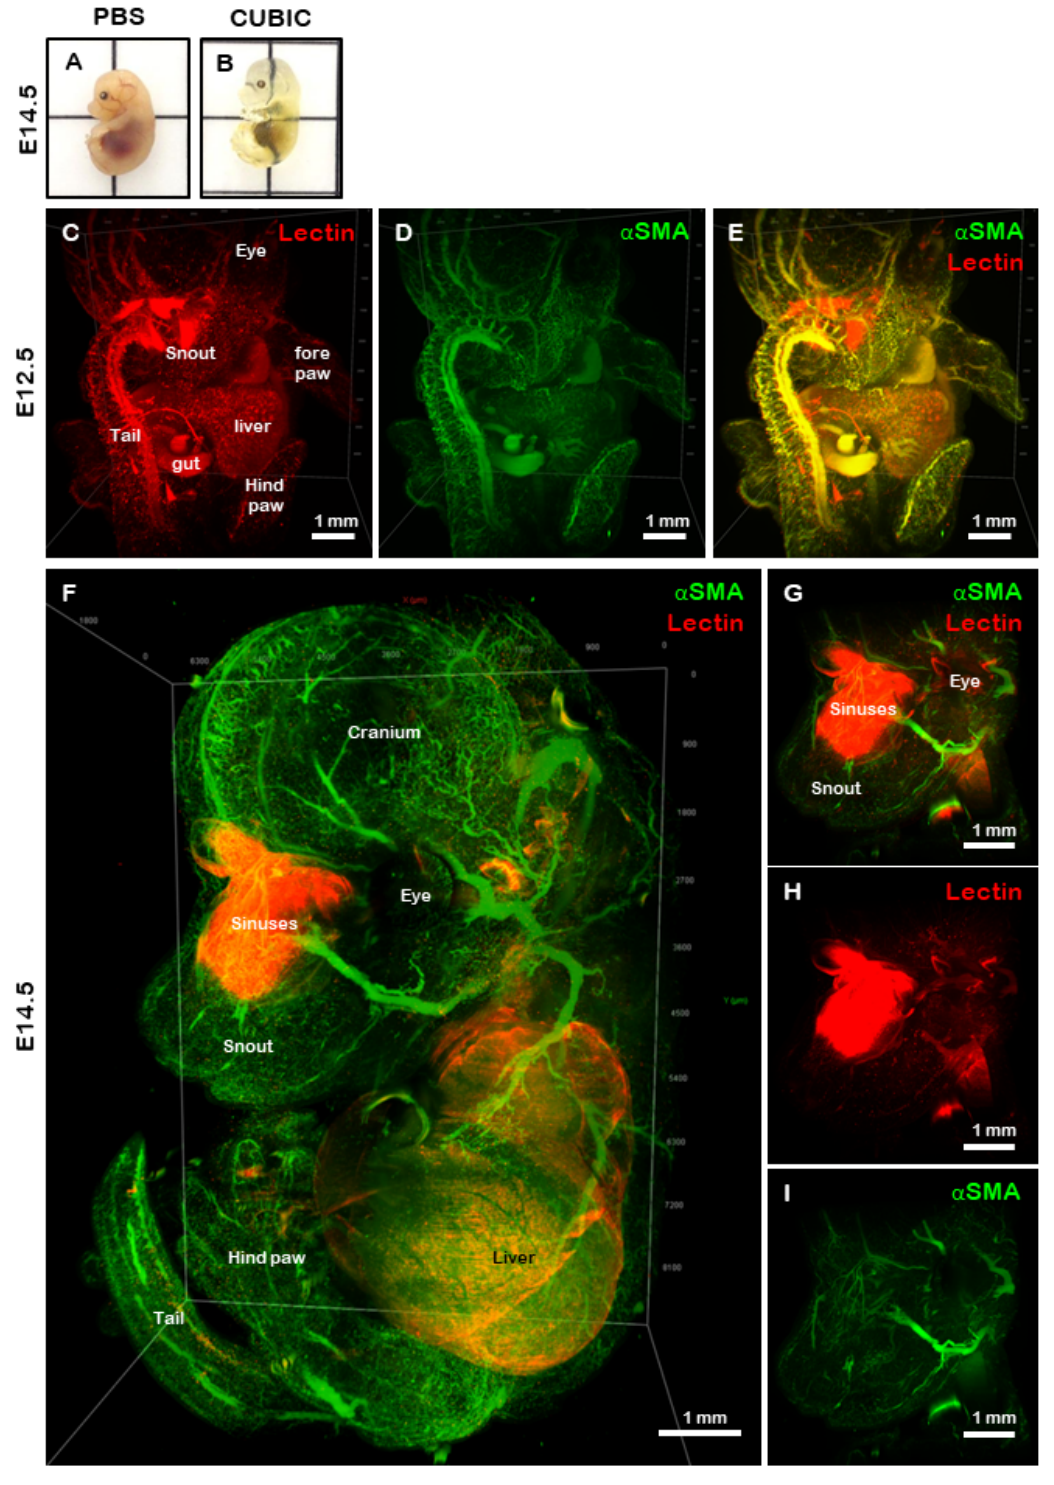
Figure 3. Light sheet fluorescence microscopy of CUBIC cleared mouse embryos. Representative images of an E14.5 embryo prior to ( A ) and following ( B ) clearing with the CUBIC protocol. To determine whether large biological samples could be embedded in high refractive index hydrogels prior to imaging, we stained and embedded mouse embryos at E12.5 ( C – E ) and E14.5 ( F – I ) ages. Embryos were stained with lectin ( C , G ) and α SMA ( D , H ) and the images were merged ( E , F , I ). Various anatomical features were visible on both E12.5 and E14.5 embryos. Scale bars in all panels represent 1 mm.